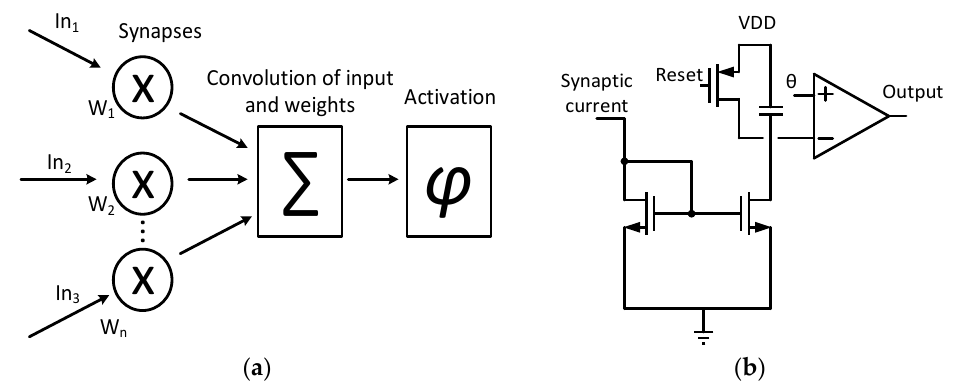
Figure 29. ( a ) Model of neuron summation; ( b ) An integrate ‐ and ‐ fire neuron.